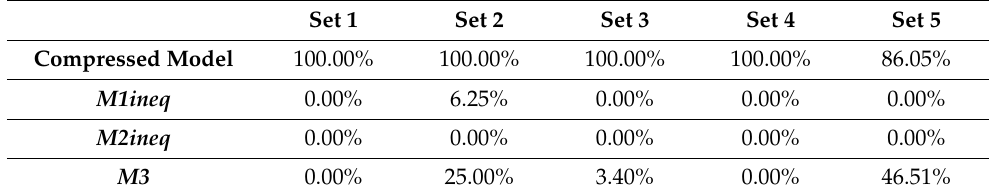
Table 9. Performance of the linear relaxation.